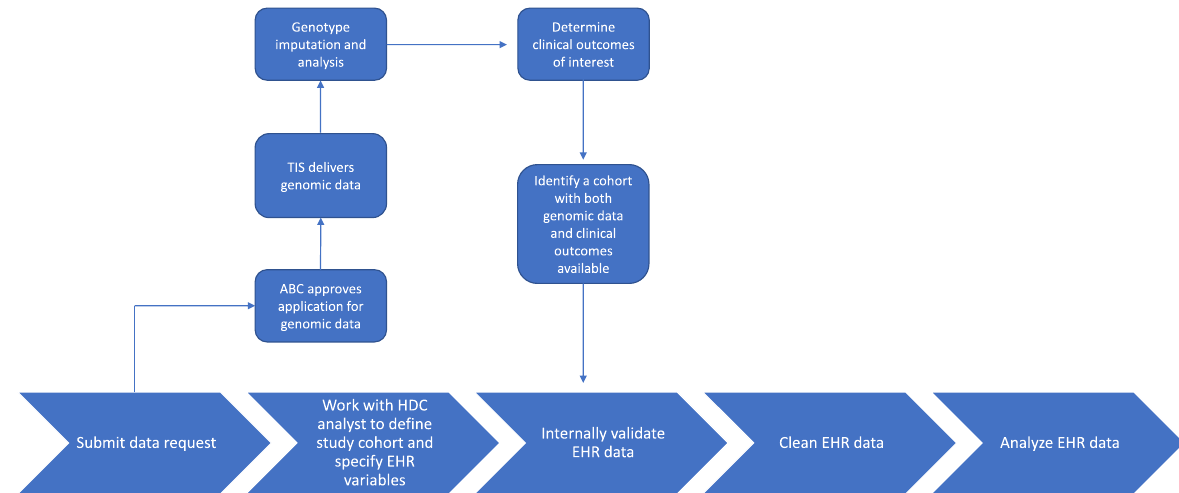
Fig. 1 Process overview for working with EHR data warehouse. ABC, Access to Biobank Committee; TIS, Translational Informatics Services; HDC, health data compass; EHR, electronic health